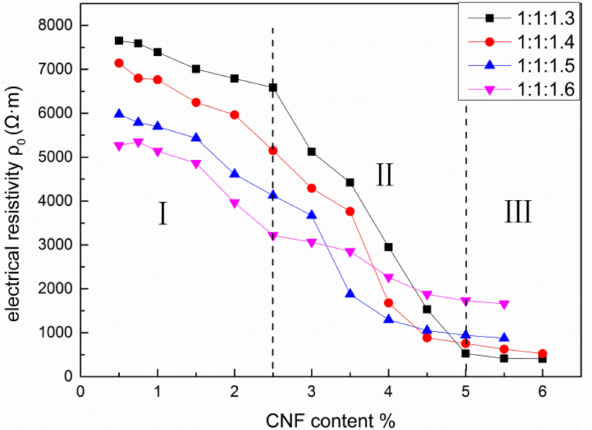
Figure 2. CNFPUC seepage curve for different CNF